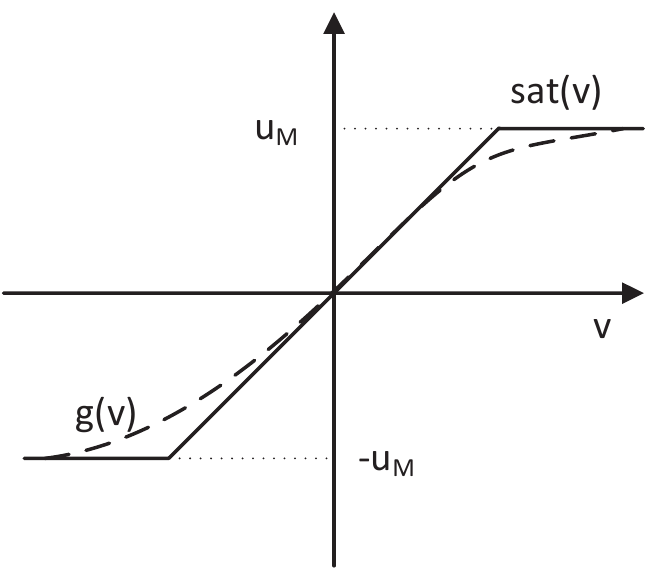
Figure 2. The principle of input